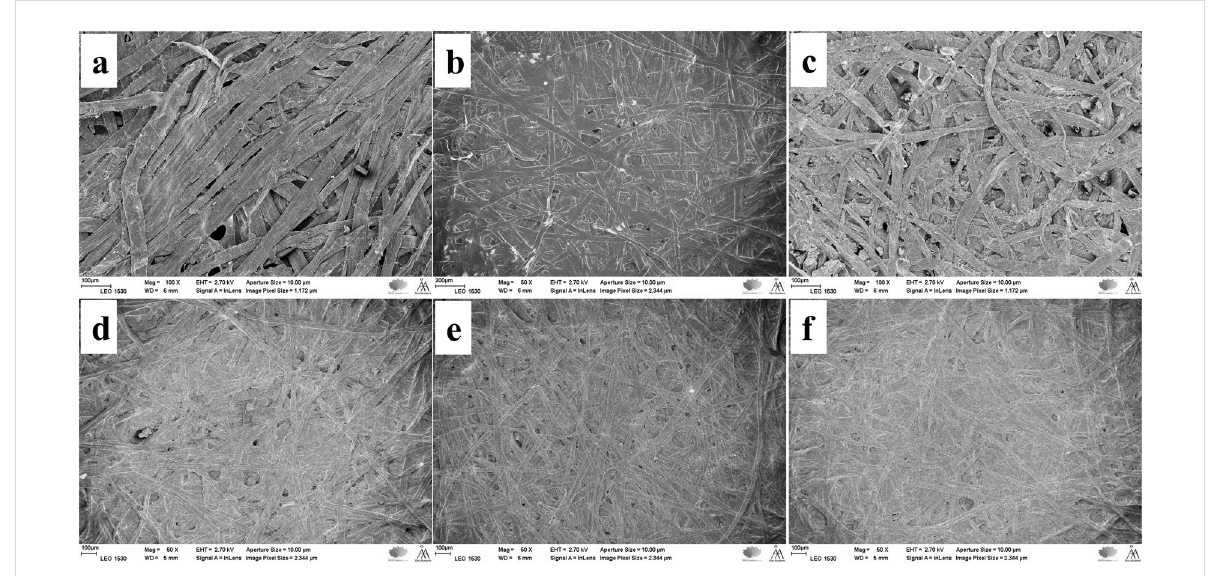
Figure 7: SEM images of the UBKP fibers: (a) REF (b) C-F (c) HF (d) C-HF (0.15 M) (e) C-HF (0.30 M) (f) C-HF (0.45 M).